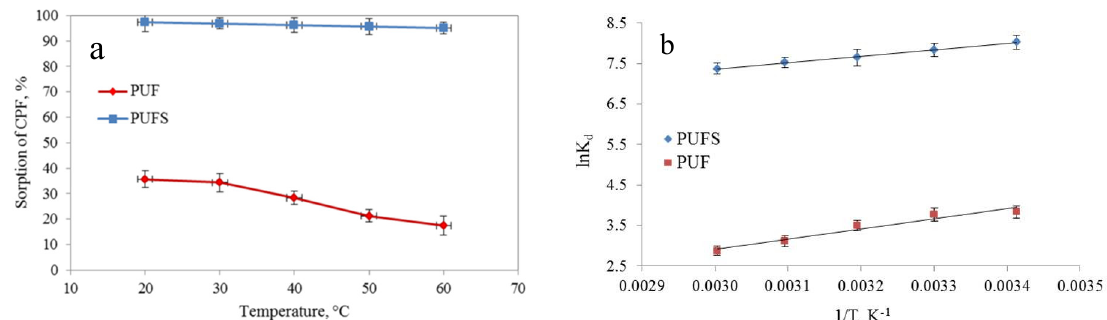
Figure 9. ( a ) Effect of temperature on CPF sorption percentage, ( b ) Van’t Hoff Equation for sorption of CPF onto white PUF and PUFS. Experimental conditions: 25 mL volume of CPF; 10.0 ± 0.02 μg/L solution (aqueous phase); adsorbent dosage 0.3 mg/L, agitation speed 100 rpm, shaking time 180 min.